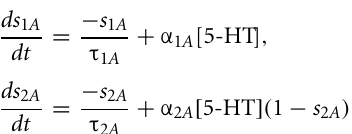
5-HT 2A receptors by inhibiting the Ca 2 + -dependent K + current ( I KCa ), and increasing intracellular Ca 2 + , which modulates in turn a non-specific cationic current ( I Can ). In interneurons (red circle), 5-HT inhibits passive leak currents ( I L ) via 5-HT 2A receptors. (C) Schematic diagram of the simulated tasks. In the no-distractor trials (left), after 3s of fixation a stimulus is presented in one of 16 possible locations. After a delay of 3s subjects have to report the location of the stimulus. In the distractor trials, a distractor stimulus is presented at location θ D during the delay (at 1.75s), and a second delay of 1.75s follows before the behavioral